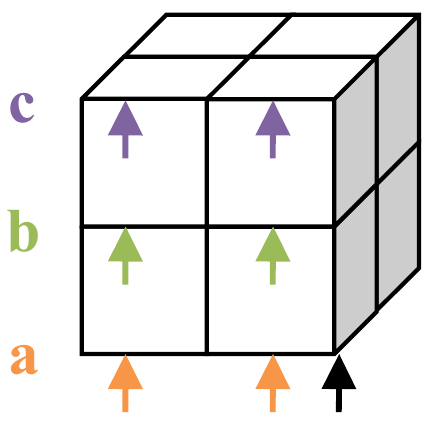
Fig. 12 Illustration of the Joint-X joints when y = 2 (for more gen- eral cases when 2 ≤ y < b + 1